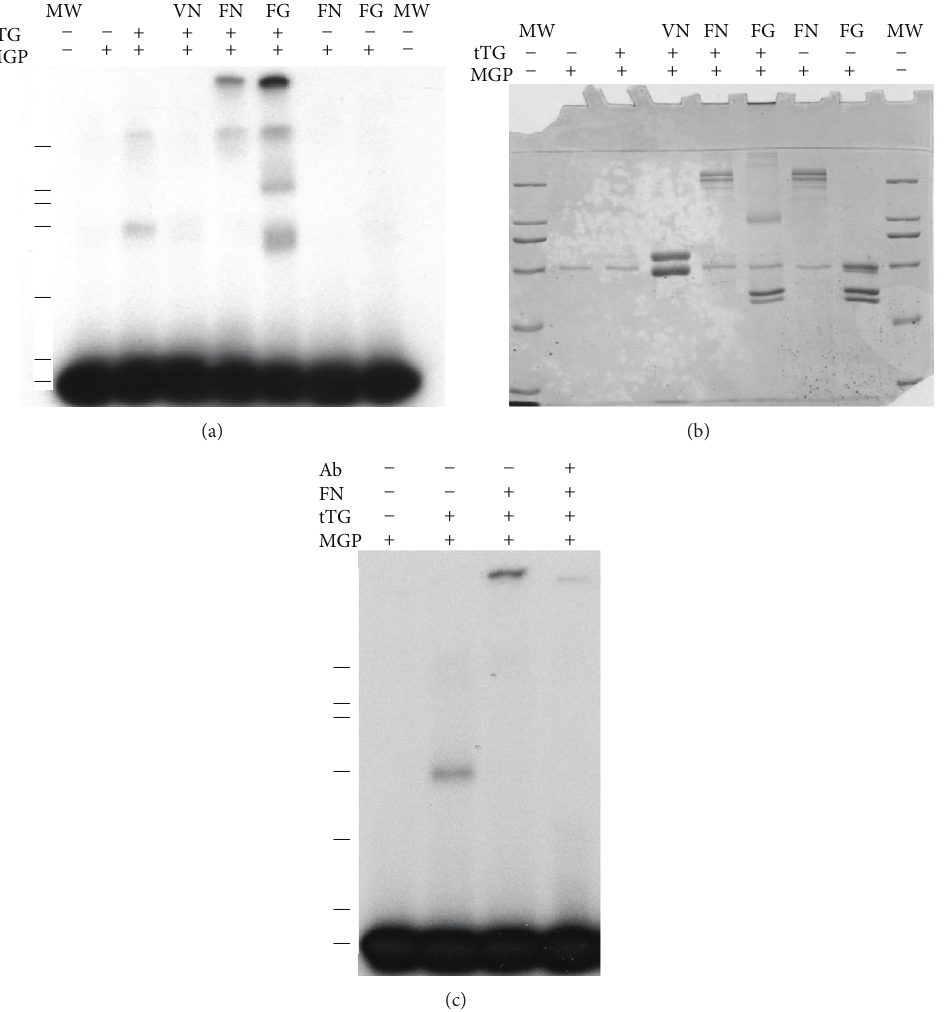
Figure 2: MGP is incorporated into crosslinked fibronectin and fibrinogen by tissue transglutaminase. SDS-PAGE of reaction products of MGP,tTG,andextracellularmatrixproteins.Linesindicate7markerpositionsof200,116,97,66,43,31,and14kDa.(a)Autoradiographof7.5% acrylamideSDS-PAGEgelthelegendaboveindicateswhether 125 I-labeledMGPortTGwaspresentas+and − symbols;Theproteinincubated with MGP is shown in the top line, VN, vitronectin, FN, fibronectin, and FG, fibrinogen. MW indicates that molecular weight markers were run in those lanes. (b) Coomassie blue stained 7.5% acrylamide SDS-PAGE gel used for autoradiograph in (a). Molecular weight markers are 200, 116, 97, 66, 43, 31, and 14kDa. MGP runs with the 14 kDa protein at the dye front on this gel. (c) Autoradiograph of 7.5% SDS-PAGE gel. The furthest right lane marked Ab+ shows inhibitory effect of added anti-MGP IgG on incorporation of MGP into crosslinked